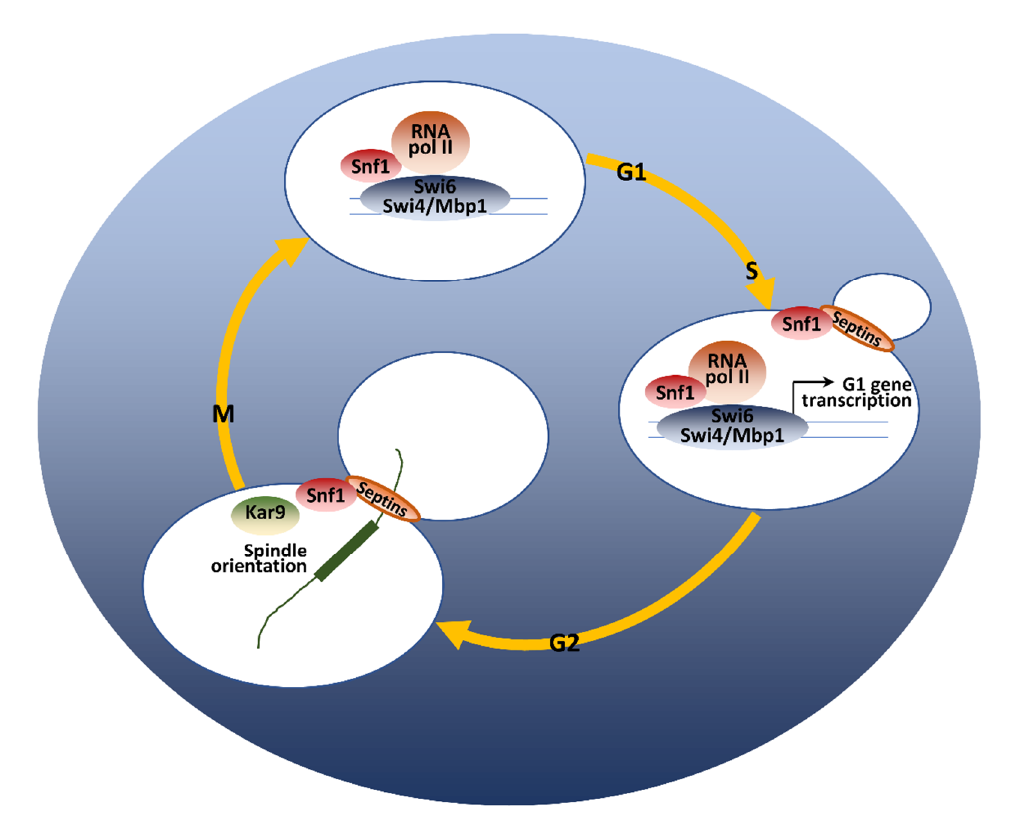
FIGURE 3 : A model of the regulatory role of Snf1 during the cell cycle. At the G1/S phase transition, Snf1 promotes the binding of Swi4, Mbp1 and Swi6 proteins to G1 promoters and favors the proper recruitment of the RNA Polymerase II. From bud emergence, active Snf1 is localized to the bud neck, in a septin-dependent manner. At the metaphase-to-anaphase transition, Snf1, as part of the Kar9-dependent pathway, promotes spindle align- ment along the mother-bud axis and guarantees proper nuclei segregation during mitosis. See text for